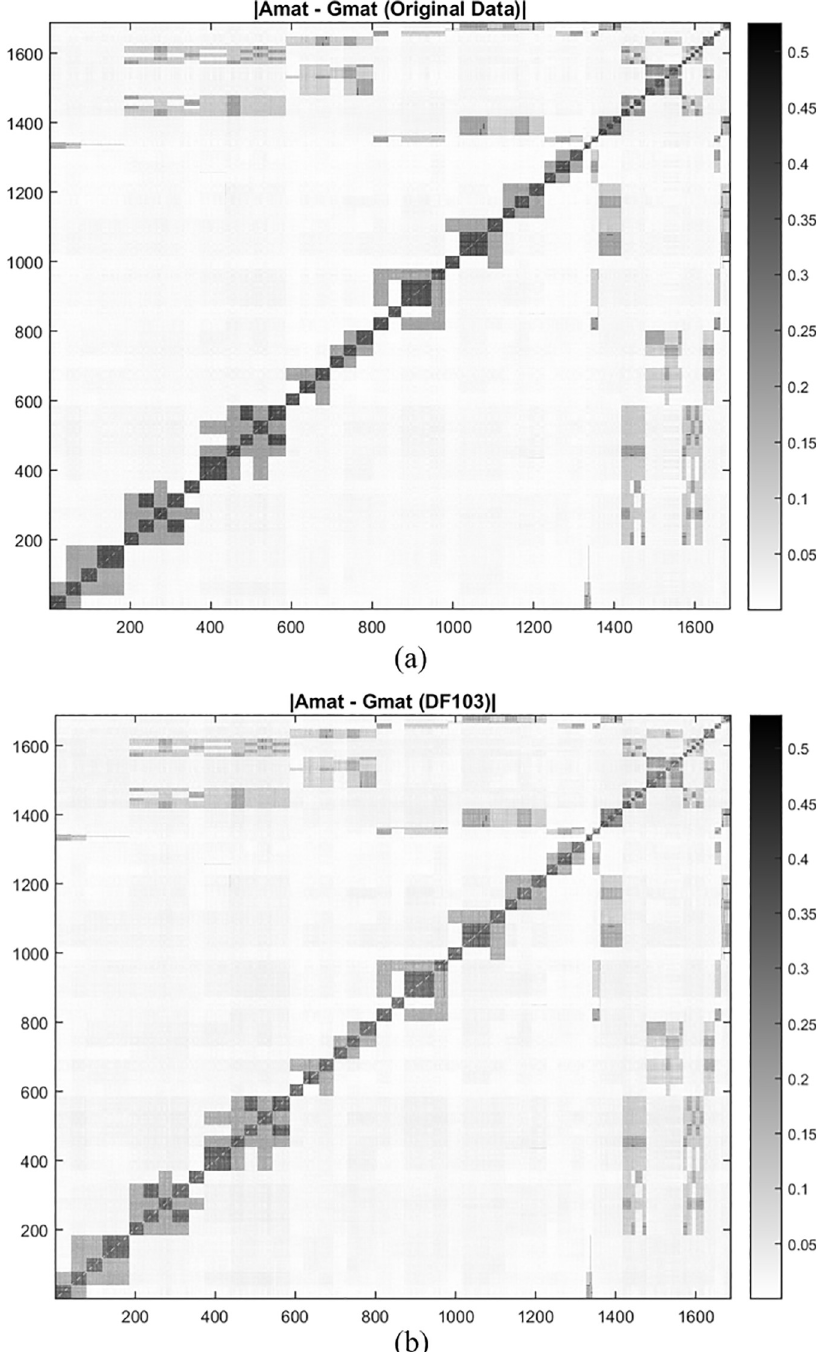
Fig 3. (a) Heatmap of the absolute difference between pedigree-based relatedness ( A -matrix) and genomic estimated relatedness ( G -matrix) generated from original data; (b) Heatmap of the absolute difference between pedigree-based relatedness ( A- matrix) and genomic estimated relatedness ( G- matrix) generated from DF103 subset. The color of Fig 3 (B) is lighter than Fig 3(A). The lighter the color, the closer the relationship between A- and G- matrices of Douglas-fir breeding